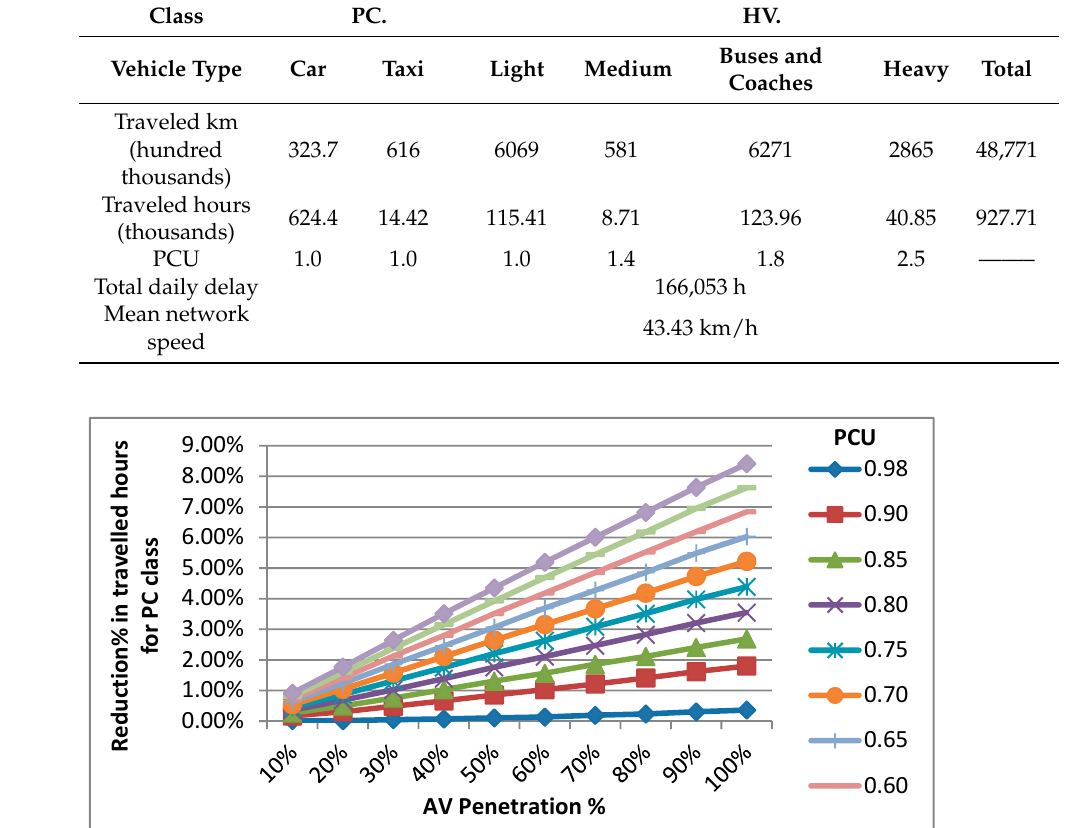
Table 1. Traffic parameters of base scenario.